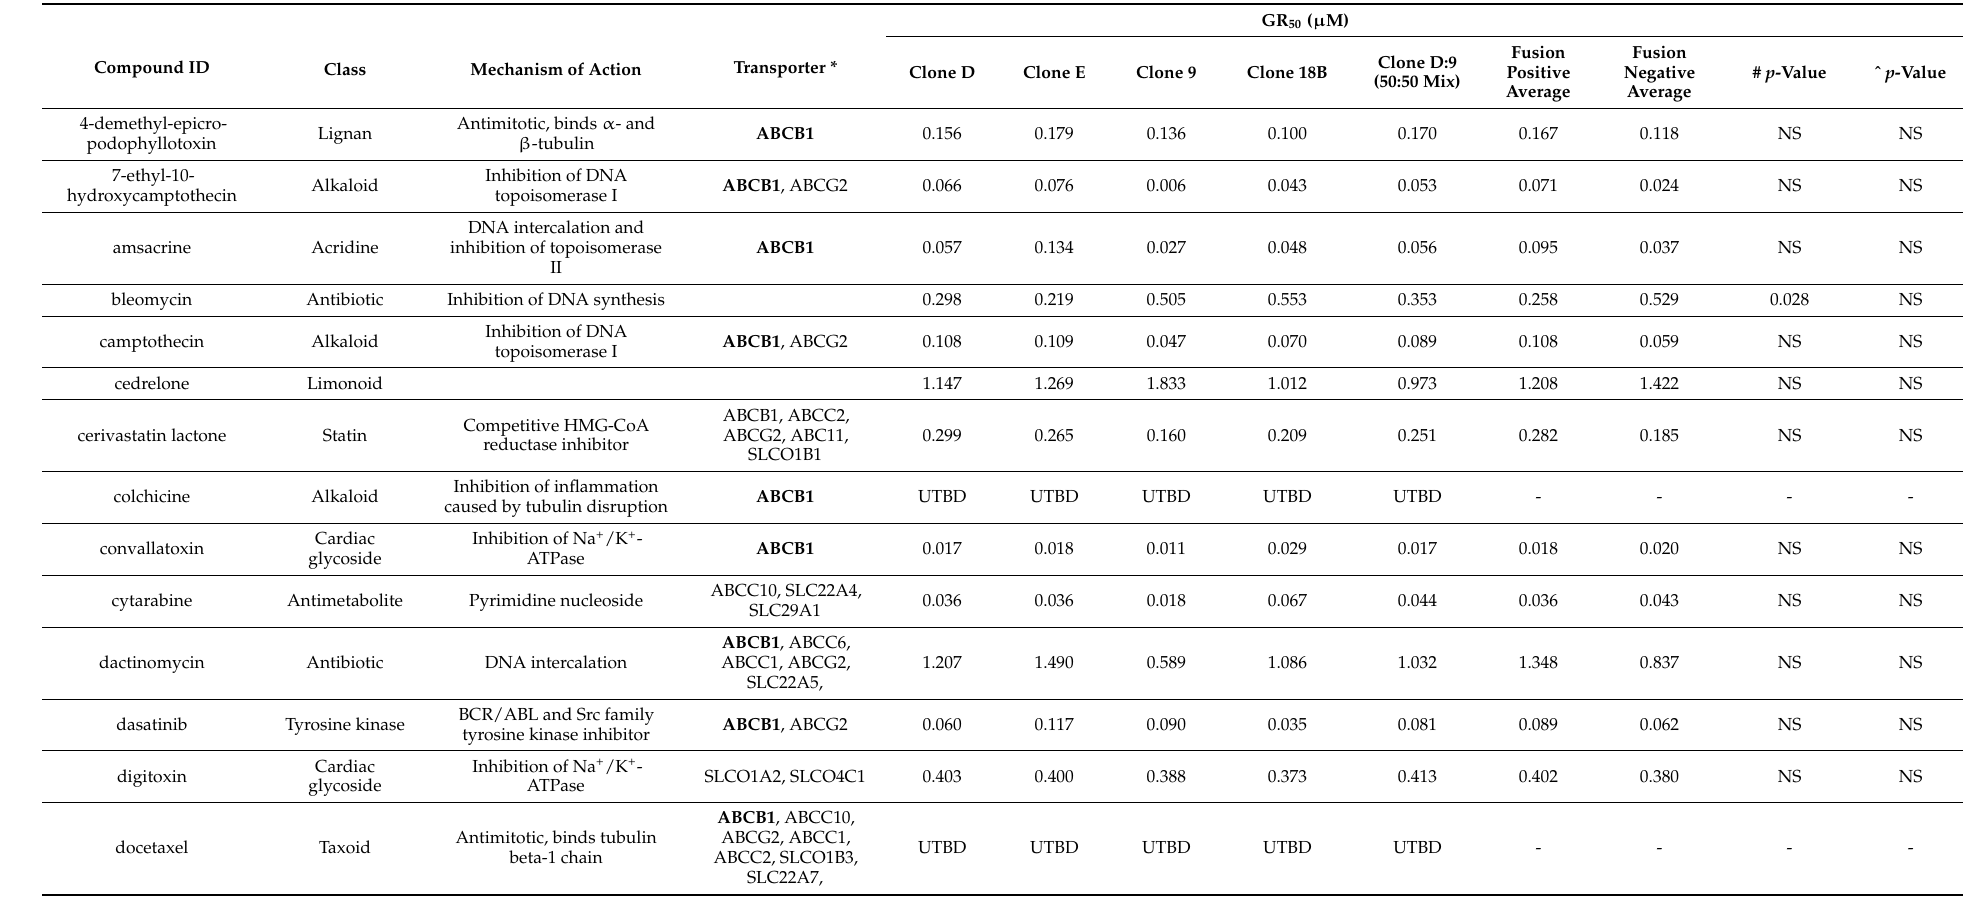
Table 2. FDA compounds that induce cytotoxicity regardless of SLC25A40-ABCB1 fusion